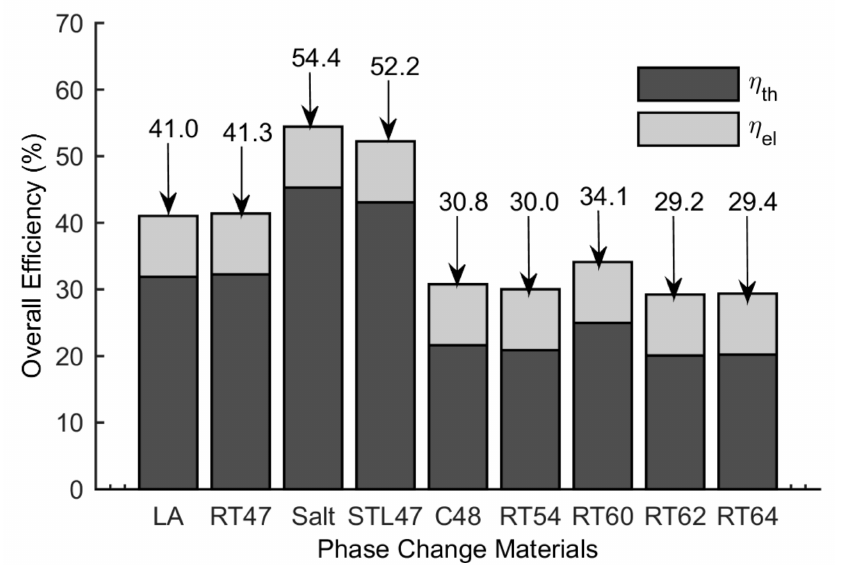
Figure 13. The overall efficiencies of a CPVPCM system.